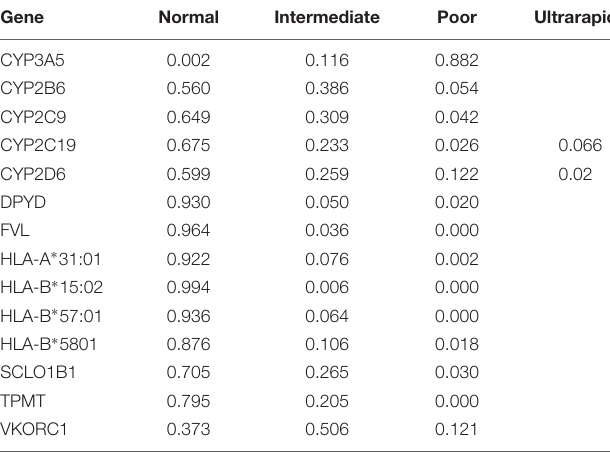
TABLE 2 | Frequency of pharmacogenes’ predicted phenotypes according to GoNL database ( n = 498).